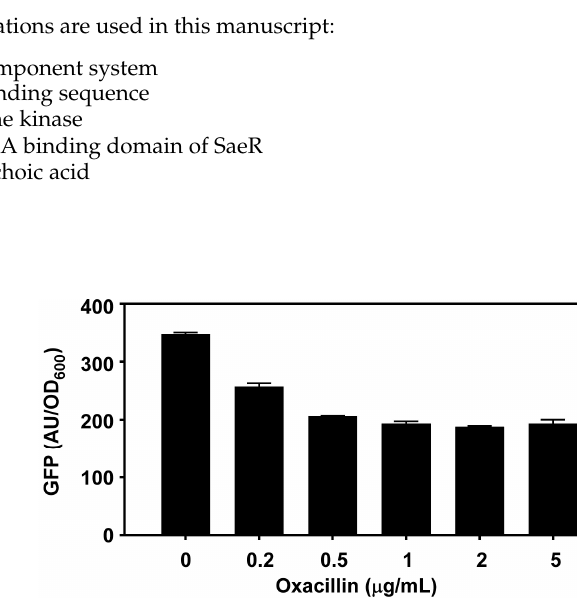
Figure A1. Effect of oxacillin on P1 promoter activity. Staphylococcus aureus USA300 carrying P1 ‐ GFP reporter plasmid [42] was grown in 150 μ L TSB at 37 °C until mid ‐ exponential growth phase. After addition of oxacillin to the concentration indicated, the culture was further incubated for 2 h at 37 °C, and OD 600 and GFP expression were measured (Enspire, Perkin Elmer, Waltham, MA, USA). AU, arbitrary unit.